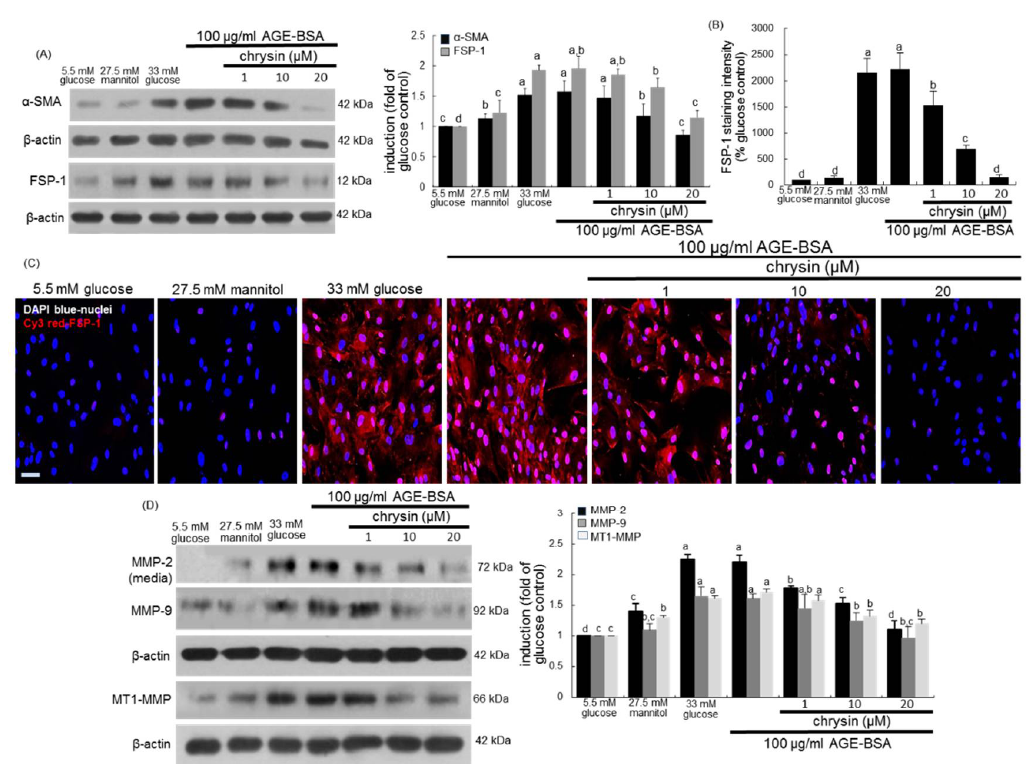
Figure 6. Suppressive effects of chrysin on cellular induction of α -SMA, fibroblast specific protein (FSP)-1, MM-2, MMP-9 and MT1-MMP in AGE-exposed HRMC. Renal mesangial cells were challenged for 3 days with 100 μg/mL AGE-BSA in the absence and presence of 1–20 μM chrysin. Cell extracts and media were subject to Western blot analysis with a primary antibody against α-SMA, FSP-1, MMP-2, MMP-9 or MT1-MMP ( A , D ). β-Actin protein was used as an internal control. The bar graphs in the right panel represent densitometric results obtained from Image analysis. The FSP-1 induction in AGE-exposed cells was immunocytochemically visualized as fluorescent Cy3 staining and nuclear counter-staining was done with the blue stain DAPI ( B , C ). Each photograph is representative of four different experiments and fluorescent images were taken with a fluorescence microscope. Scale bar = 100 μm. Fluorescent Cy3 staining intensity of FSP-1 was measured using an optical Axiomager microscope system ( B ). Values in bar graphs (mean ± SEM, n = 3 independent experiments) not sharing a same lower case indicate significant different at p < 0.05.